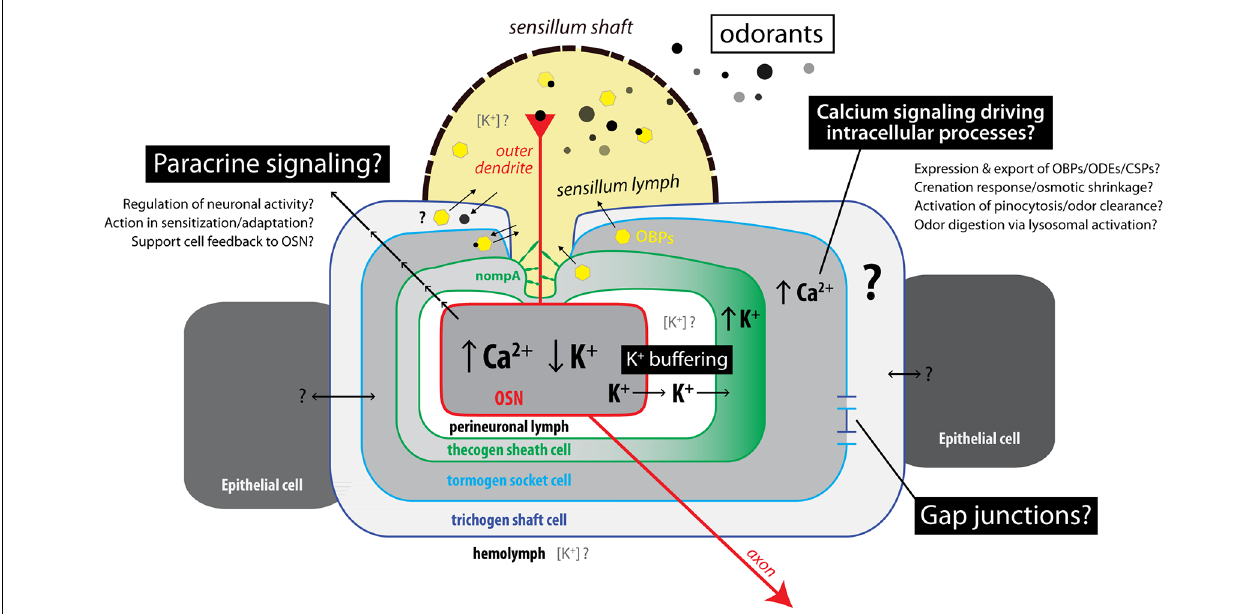
FIGURE 6 | Summary model of interactions between cells in insect sensilla during odor sensing. Illustration of known, hypothesized, and unknown mechanisms of interaction between sensory neurons and supporting cells. Upon odor detection, OSNs show increasing Ca 2+ concentration and decreasing K + concentration. Support cells concomitantly respond in different ways depending on cell type. Thecogen cells are implicated in K + homeostasis and buffering of the perineuronal milieu due to K + influx, while tormogen cells acutely respond during odor presentation with cytosolic Ca 2+ rises, which may act as an intrinsic regulatory mechanism for tormogen cell activity such as odor clearance via endocytosis, or release of accessory proteins. Local (paracrine) signaling and support cell interconnection via gap junctions may also account for coupling of support cell activation to sensory neuron activity within insect